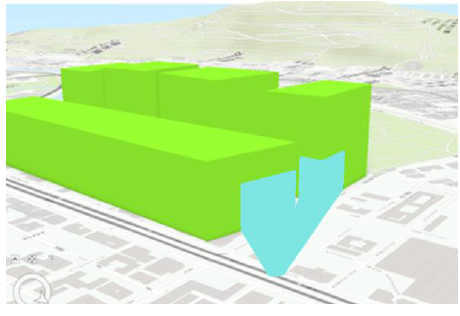
Figure 11 The coverage of single CCTV When more than one CCTV are considered, the visible coverage